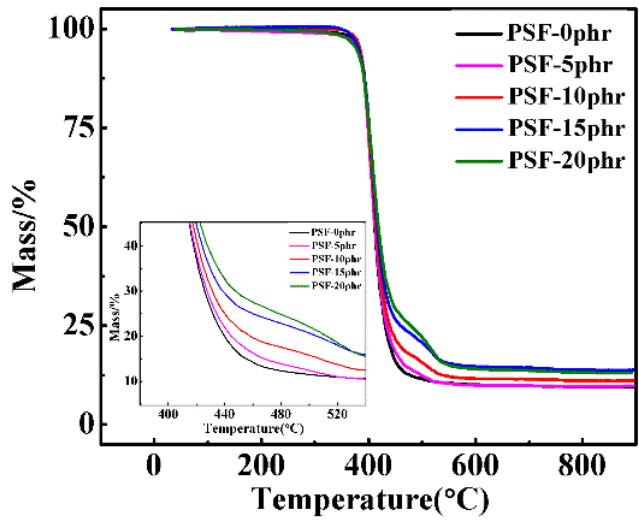
Figure 13. Thermogravimetric curves of PSF/epoxy cured products with different PSF contents.